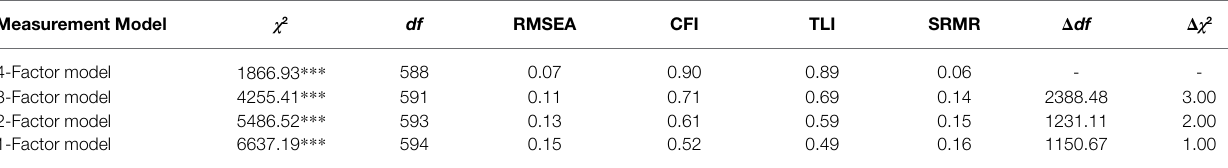
TABLE 1 | Chi-square difference tests and goodness-of-fit statistics for alternative measurement models. Measurement Model